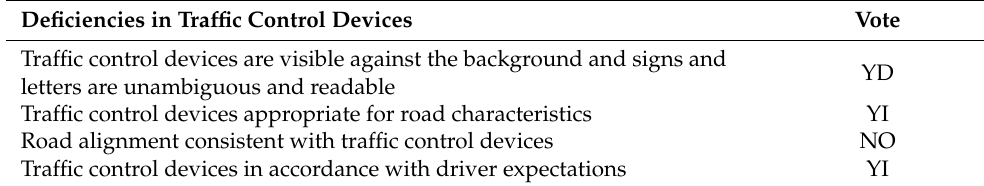
Table 15. Evaluations of the “deficiencies in traffic control devices” investigation